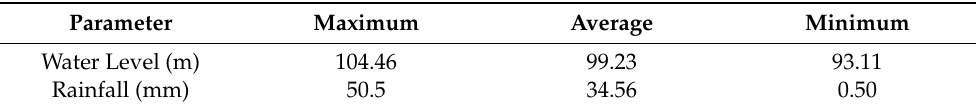
Table 1. Statistical details of